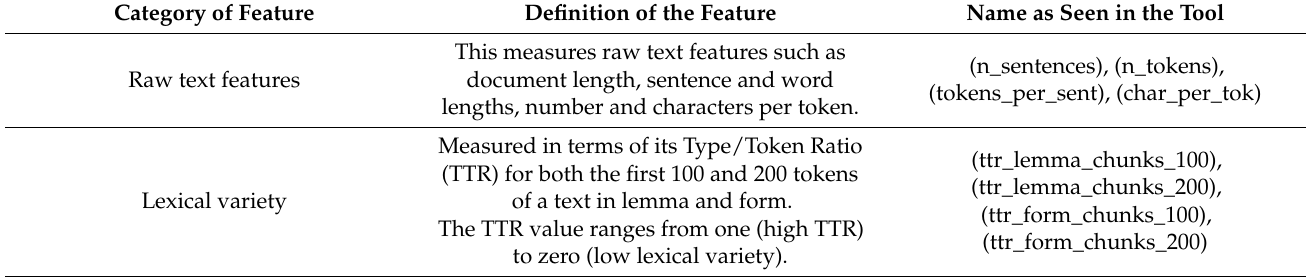
Table 1. Features extracted from